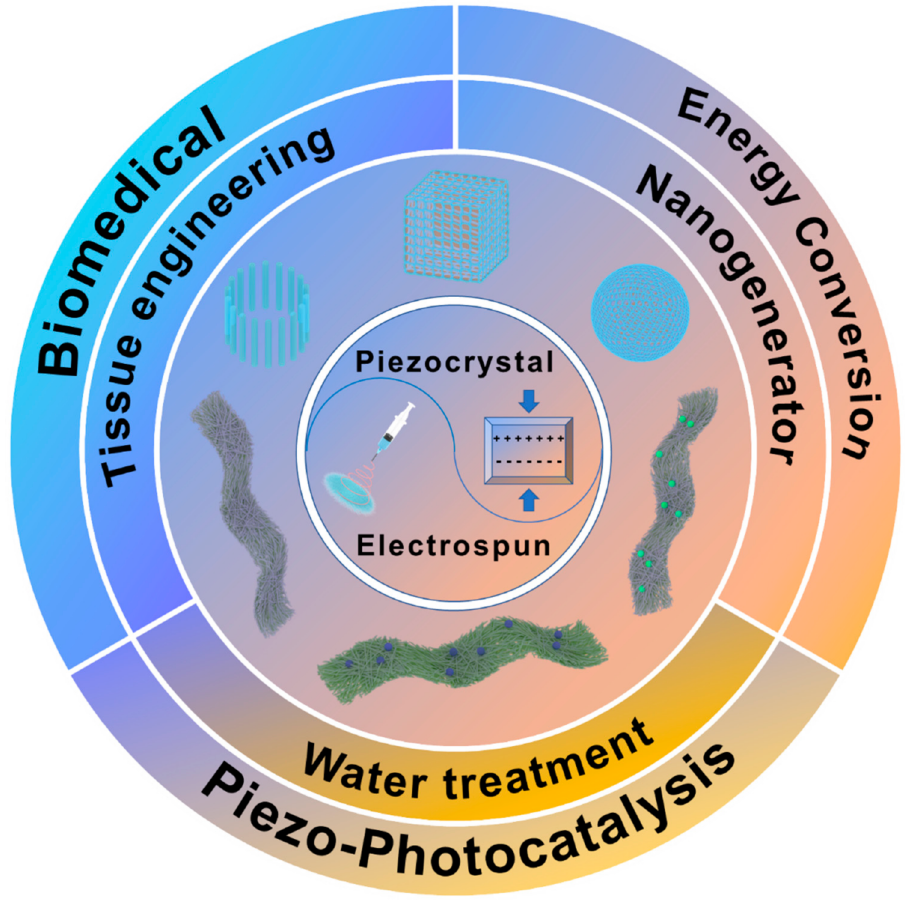
Figure 11. Application of electrospun piezoelectric